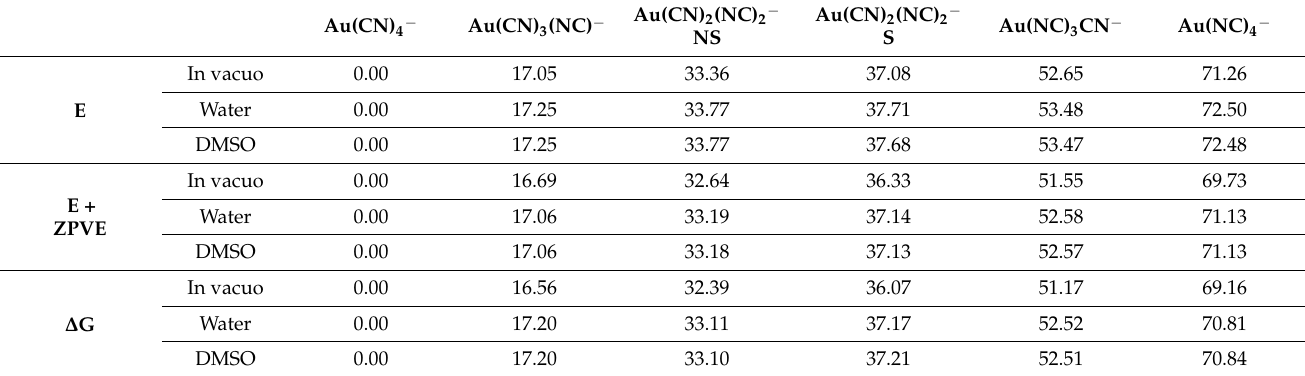
Table 2. Energy (E); energy corrected by the zero-point vibrational energy (E + ZPVE); Gibbs free energy ( ∆ G) of the linkage isomers of gold(III) tetracyanide. In vacuo—results obtained without solvation. Water and DMSO—results obtained using PCM implicit solvation model. NS indicates the non-symmetric isomer in which the CN − are next to each other. S indicates the symmetric isomer in which the CN − are opposite to each other. All values are in kcal/mol. The values in each row are provided relative to the Au(CN) 4 − .